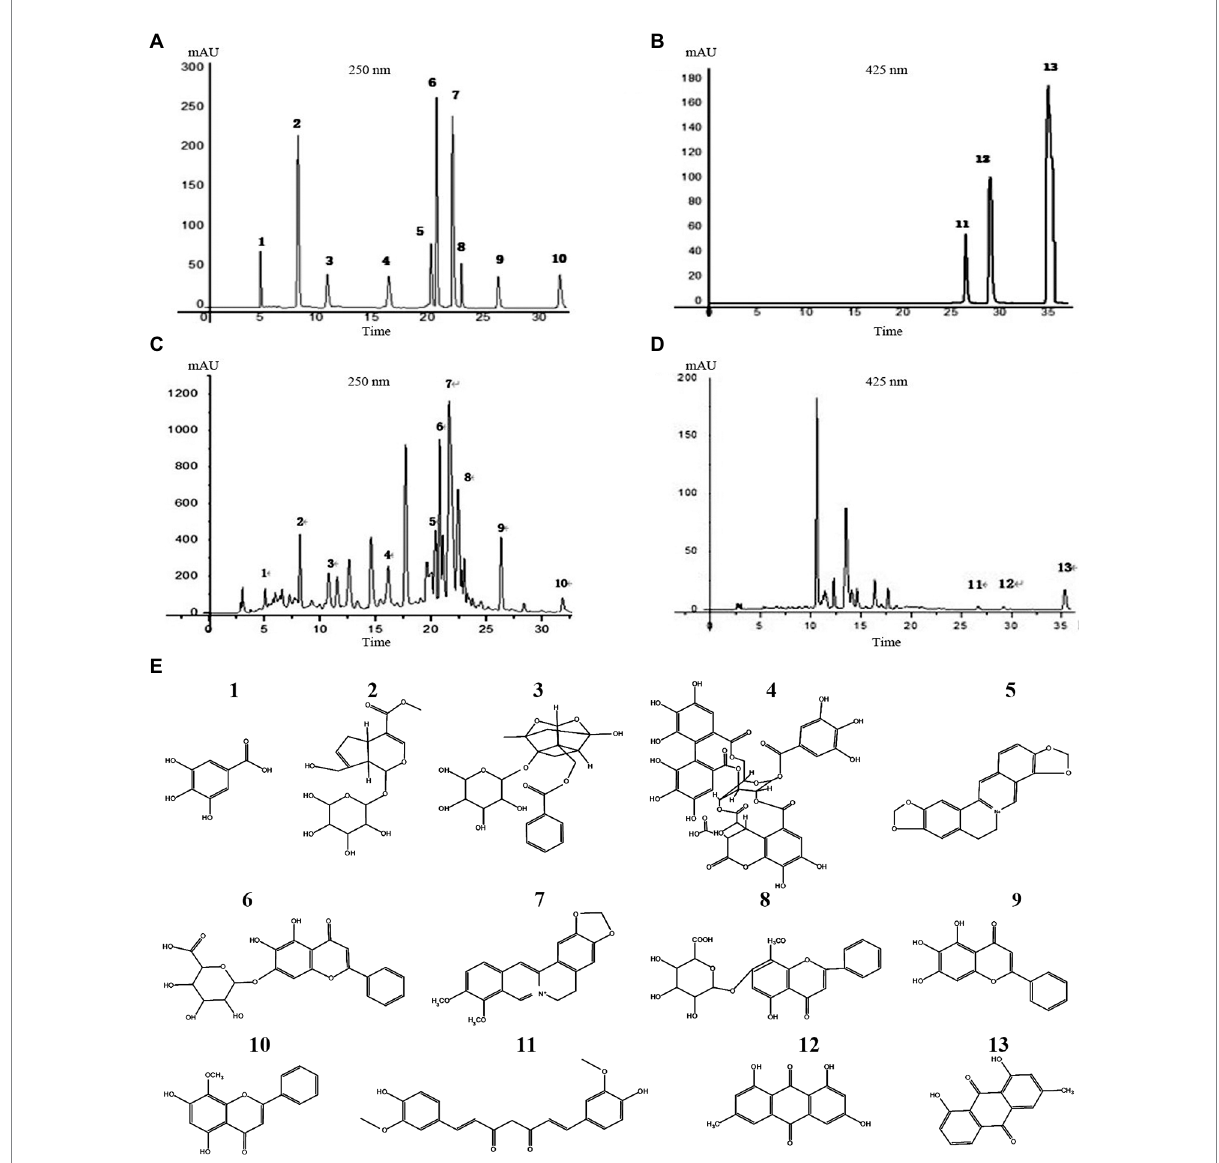
FIGURE 2 HPLC chromatogram of standard solutions (A,B) , YJP-A sample solutions (C,D) . The structural formula of chemical compounds in YJP-A (E) : 1. gallic acid; 2. gardenoside; 3. paeoniflorin; 4. chebulinic acid; 5. coptisine; 6. baicalin; 7. berberine; 8. wogonoside; 9. baicalein; 10. wogonin; 11. curcumin; 12. emodin; 13.